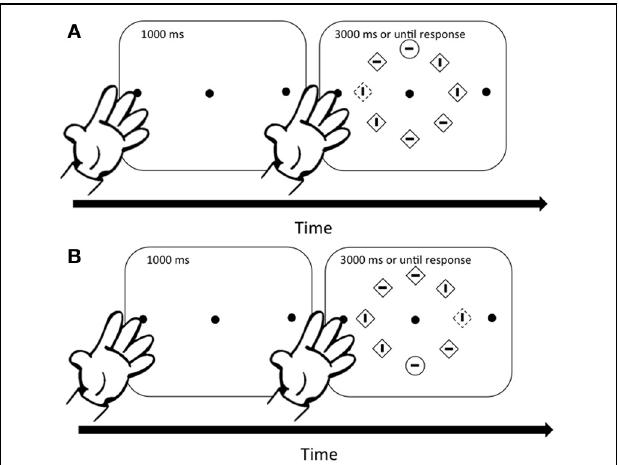
FIGURE 1 | Sequence of events for Experiments 1A,B. A fixation dot preceded each search display by 1000-ms. The search display remained on the screen for 3000-ms or until response. Color singletons appeared on 50% of the trails. In (A) the color singleton appears on the horizontal meridian near the hand and the target appears on the vertical meridian. In (B) , the color singleton appears on the horizontal meridian far from the hand and the target appears on the vertical meridian.